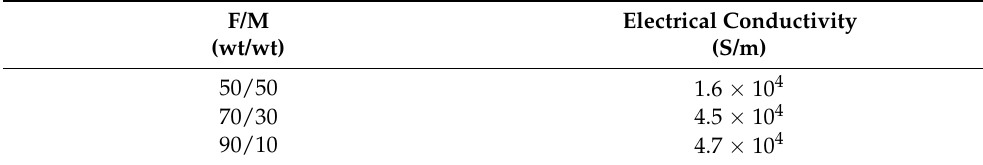
Table 4. Electrical conductivity of compact GNP/Epoxy films.